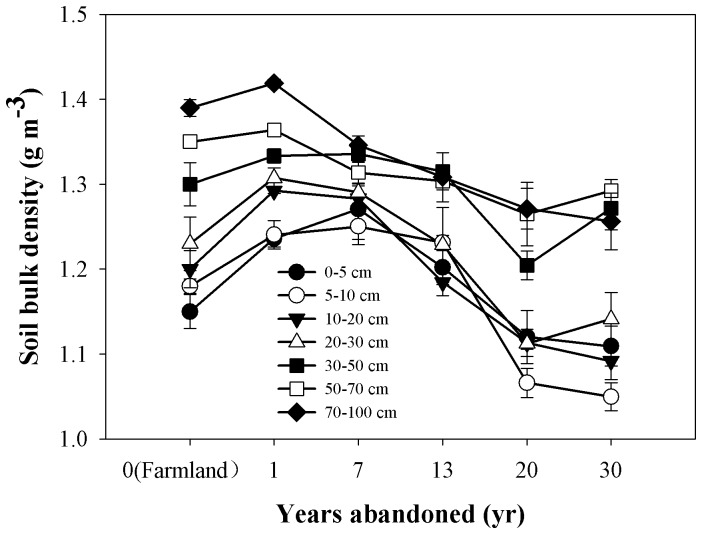
Dynamics of soil bulk density in 0–100 cm soil depth following the conversion of farmland to grassland.Values are in the form of Mean ± SE and the sample size n = 5.